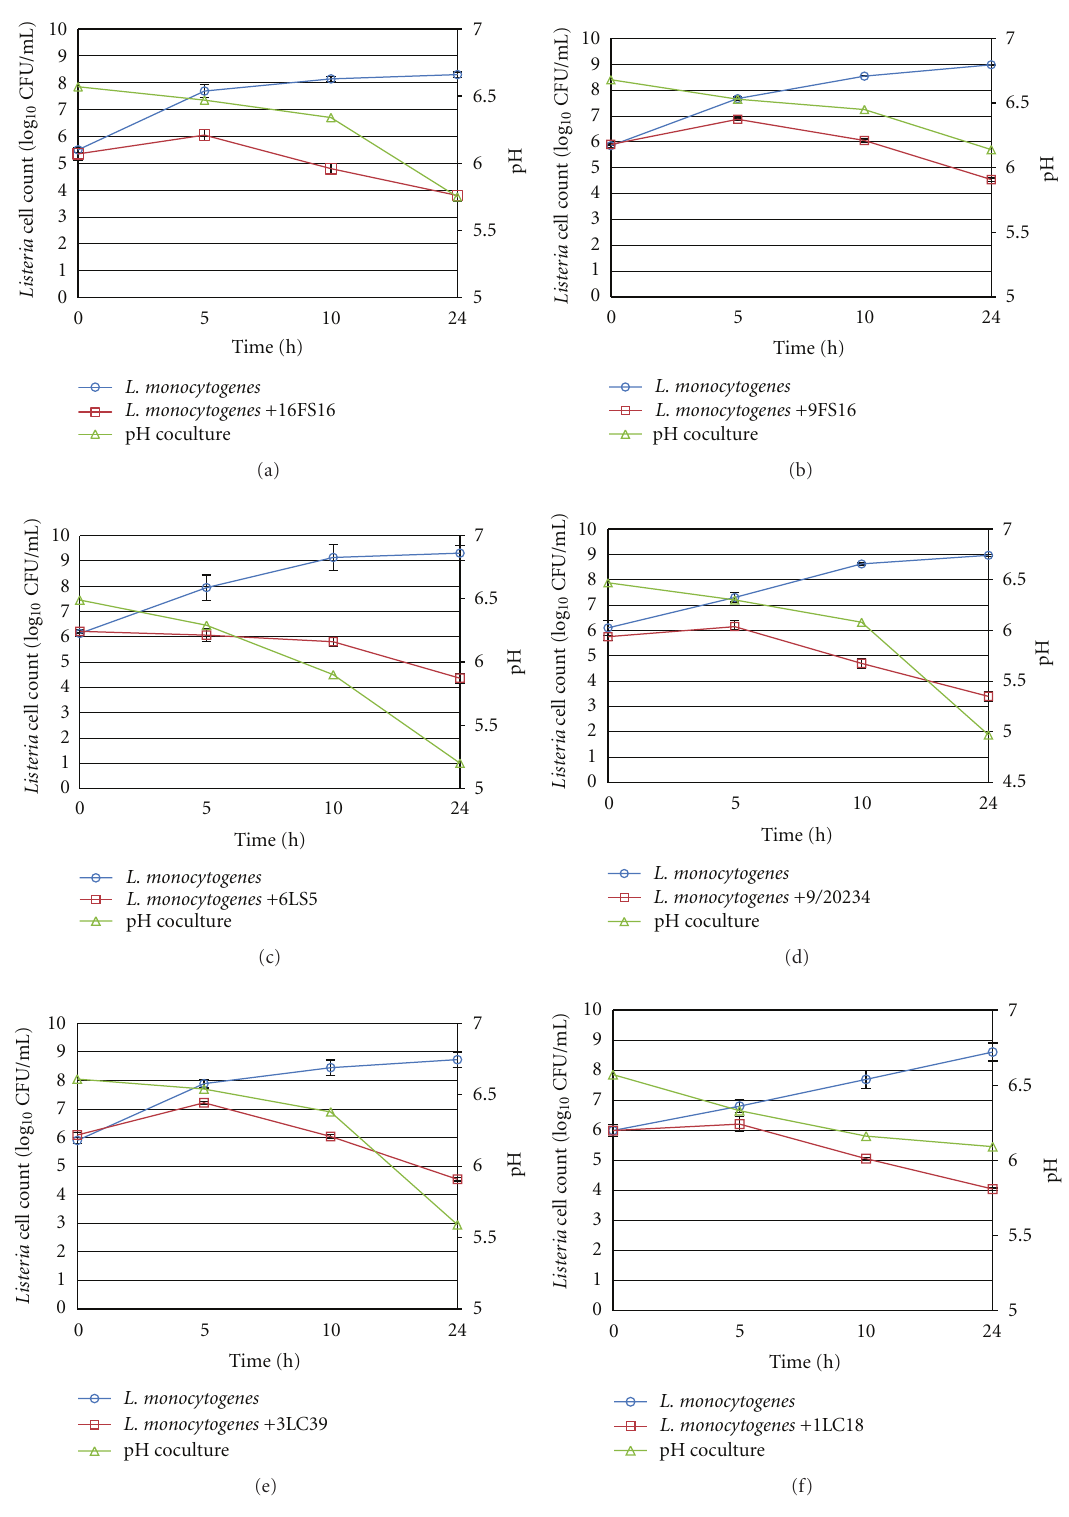
Figure 2: Growth of Listeria monocytogenes in co-culture with Lactococcus lactis subsp. lacti s bacteriocin-producing strains. Microbial counts were calculated as the number of colony-forming units (CFU) per mL and reported as log 10 CFU/mL. Data are expressed as mean ± standard errors from two independent experiments each with two